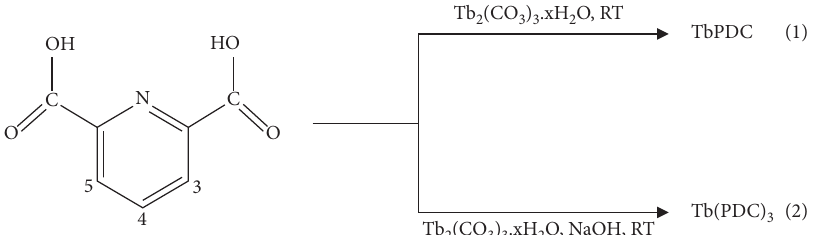
Scheme 1: Synthetic procedures of the Tb(III) complexes: (pyridine-2,6-dicarboxylato)terbium (1 + ) (TbPDC) and tris(pyridine-2,6- dicarboxylato)terbium (3 − ) (Tb(PDC) 3 ). Table 1: IR bands (cm − 1 ) of the pyridinedicarboxylate-Tb(III) complexes. Complex